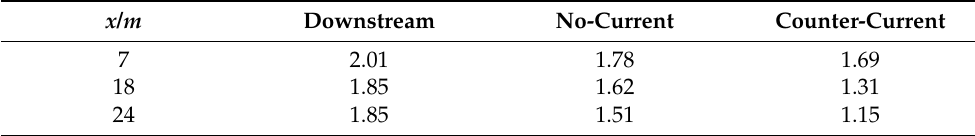
Figure 17. Frequency domain plots of wave simulation results at three points x = 7 m (a), 18 m (b), and 24 m (c) of MIKE 21 BW model. in downstream ( ╳ ), no-current ( ○ ), and counter-current ( △ ).